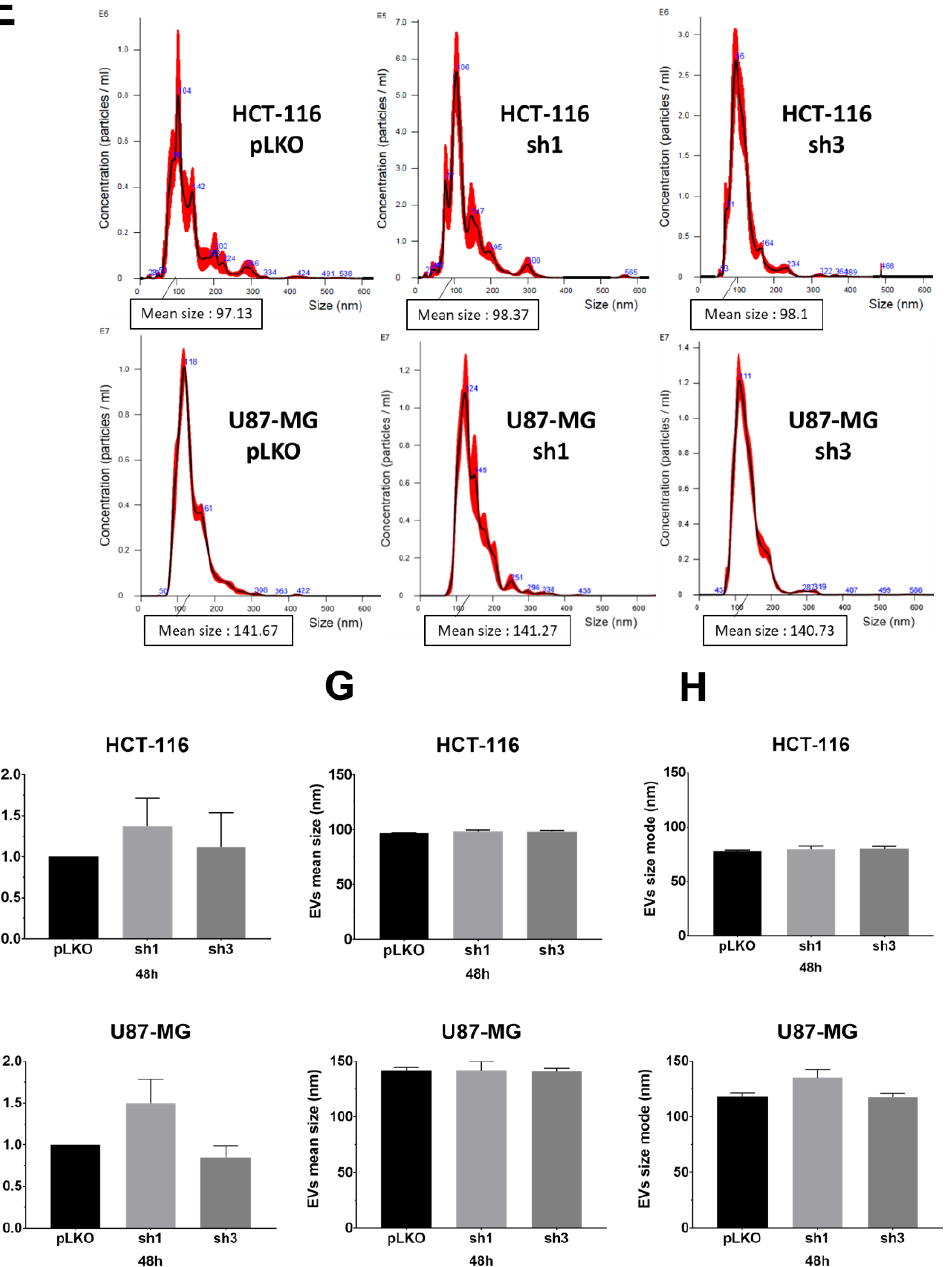
Figure 2. NTA analysis of extracellular vesicles from HCT-116 and U87-MG pLKO vs. shRAB27A. ( A )—Evaluation of the size repartition of the EVs secreted by the HCT-116 (upper panel) and U87-MG (lower panel) pLKO and shRAB27A cell lines. The cells were cultured as mentioned in the material and methods, and the supernatants were directly analyzed using the Nanosight300. Most of the EVs population is comprised of between 50 and 180 nm, which is the size range commonly given to exosomes ( n = 3). ( B )—Concomitantly with the supernatant collection, cells were counted, and the EVs/cell ratio was calculated for each cell line. There is no difference concerning this ratio between pLKO and shRAB27A cell lines. ( C )—EVs mean size (nm) from each cell line after 48 h of culture in EFM. ( D )—EVs size mode (nm) from each cell line after 48 h of culture in EFM. There is no difference between the control and shRAB27A cell lines in both U87-MG and HCT-116, n = 3. ( E – H )—The same analysis of EVs characteristics was performed at the same time (48 h) after the ultracentrifugation of the supernatant, according to Théry’s protocol ( n = 3).